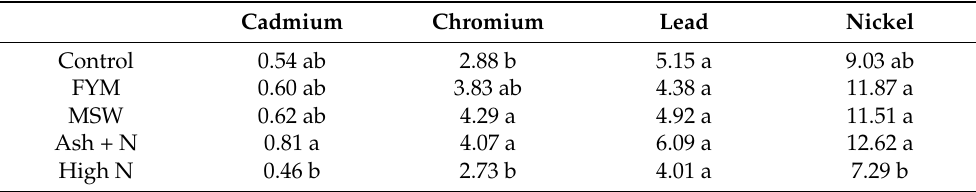
Table 3. Leaf concentration of trace metals in the sampling of July 2018, following the second application of fertilizers and amendments.